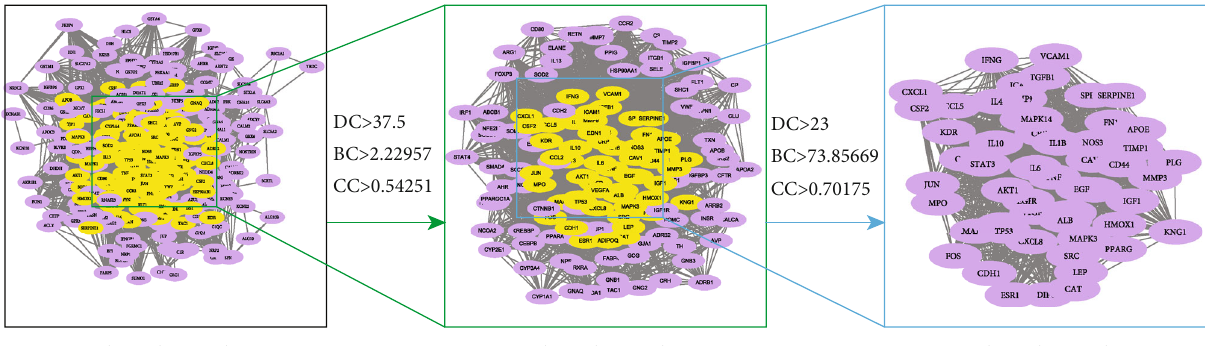
304 nodes and 6369 edges 135 nodes and 3881 edges 54 nodes and 1298 Figure 3: Topology analysis DH, the yellow node represents the Prunella vulgaris L, the blue node is the drug active compounds, and the green node is the key target of the disease and drug active compounds.